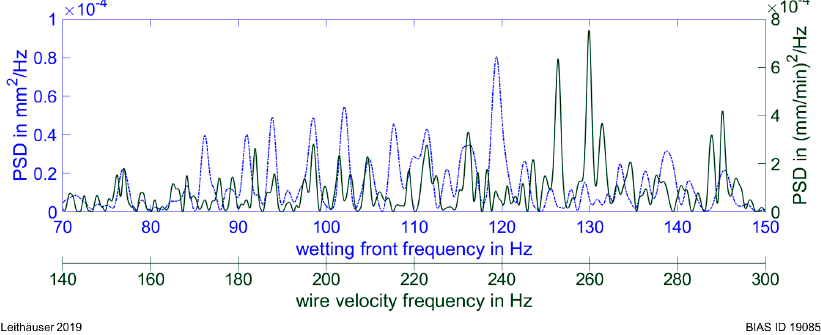
Figure 10. PSD of the wire velocity and, at half scale, the wetting front of one representative sample.